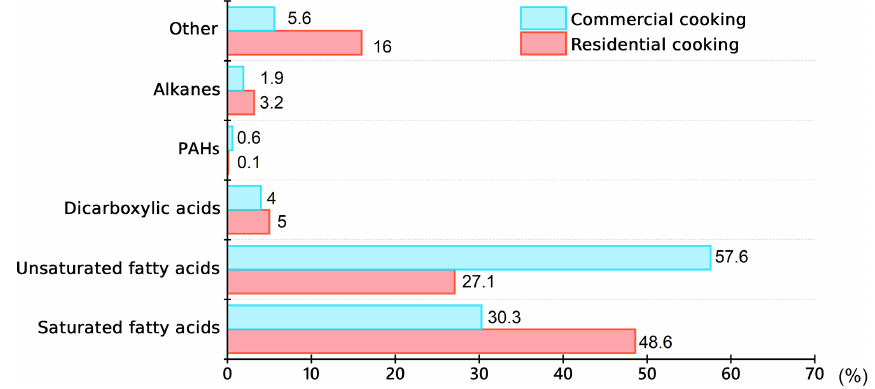
Figure 14. Proportions of major organic compounds in quantified OM emission from commercial cooking (Pei et al., 2016) and residential cooking (Zhao et al., 2015b). PAHs refer to polycyclic aromatic hydrocarbons.